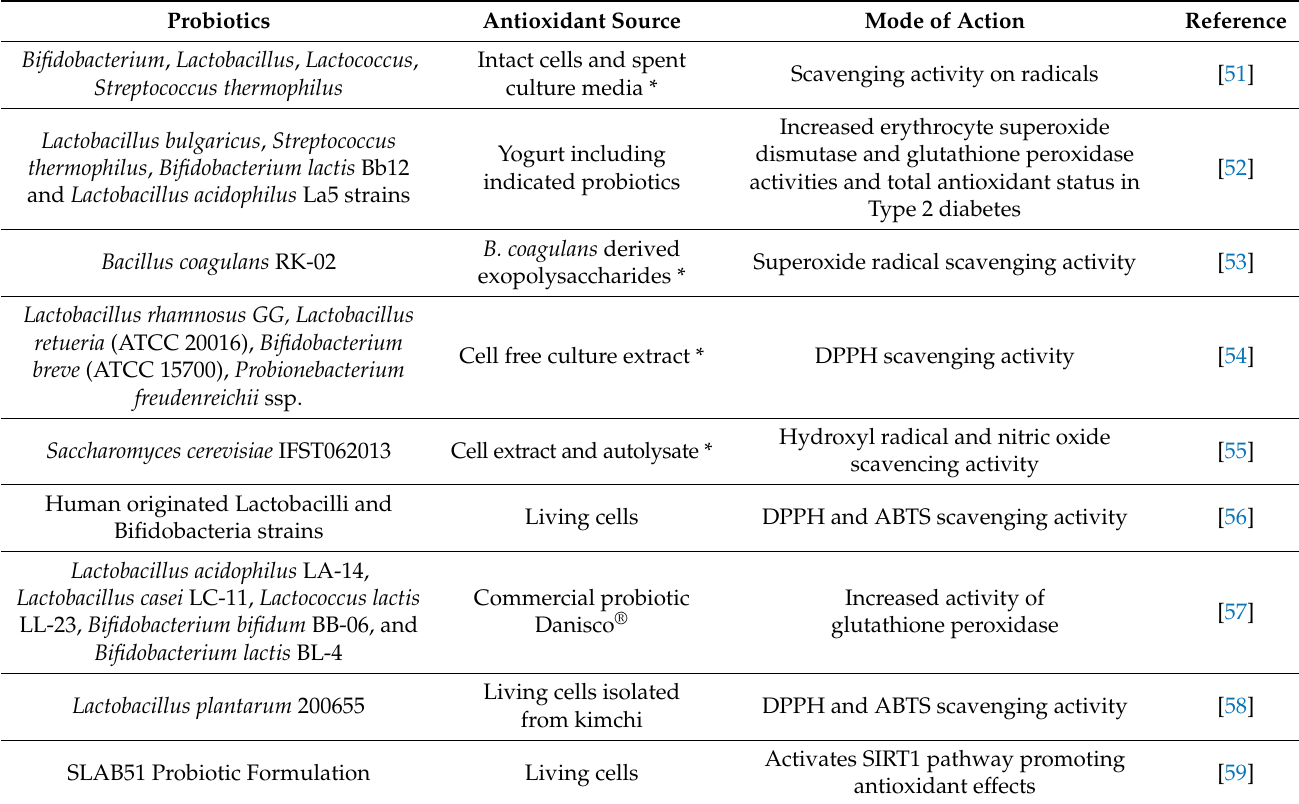
Table 1. Probiotic bacteria and their postbiotic mediators as antioxidant agents.